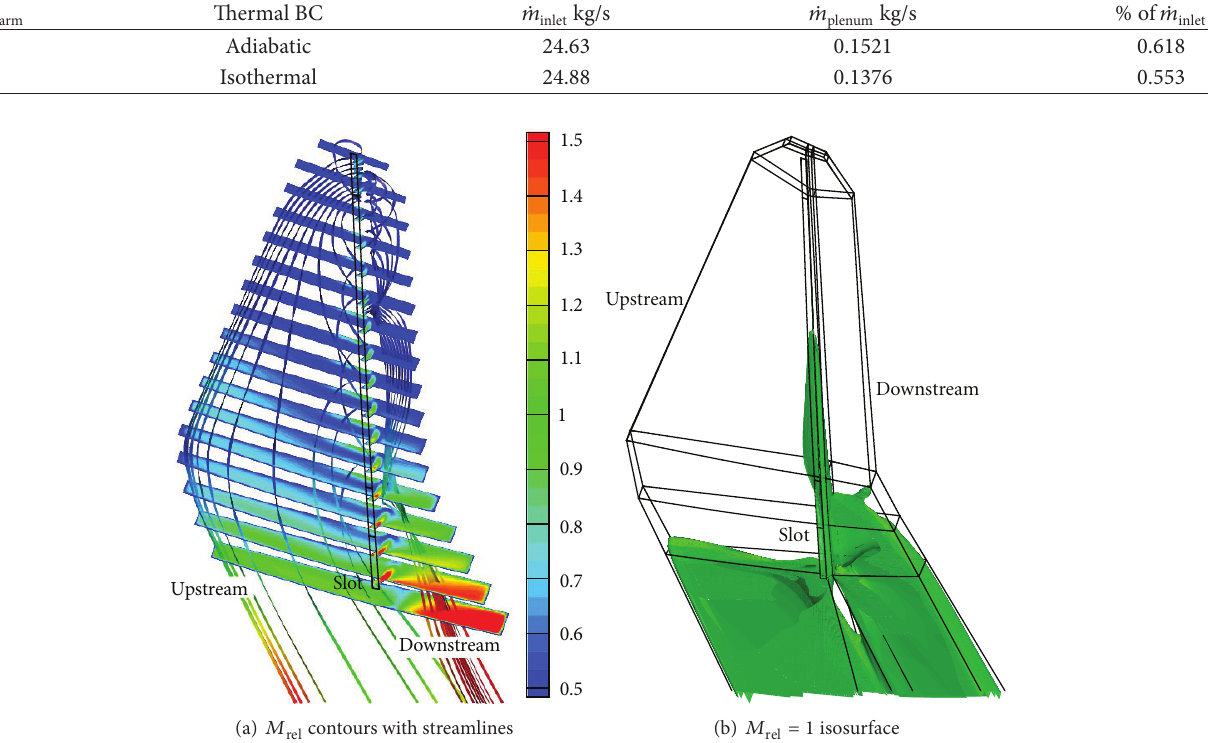
contours and isosurface for the adiabatic 𝑀𝑀 rel